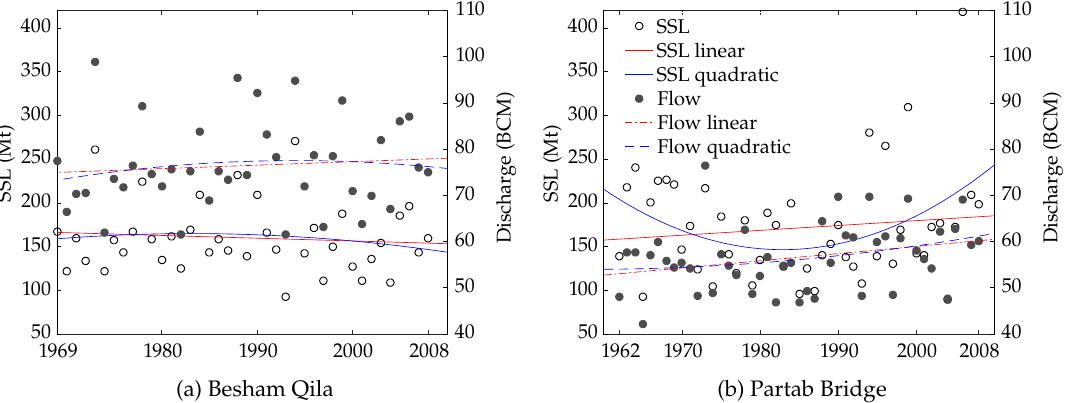
Figure 5. Linear and quadratic annual trends of reconstructed SSLs and observed discharges (legends for ( b ) also apply for ( a